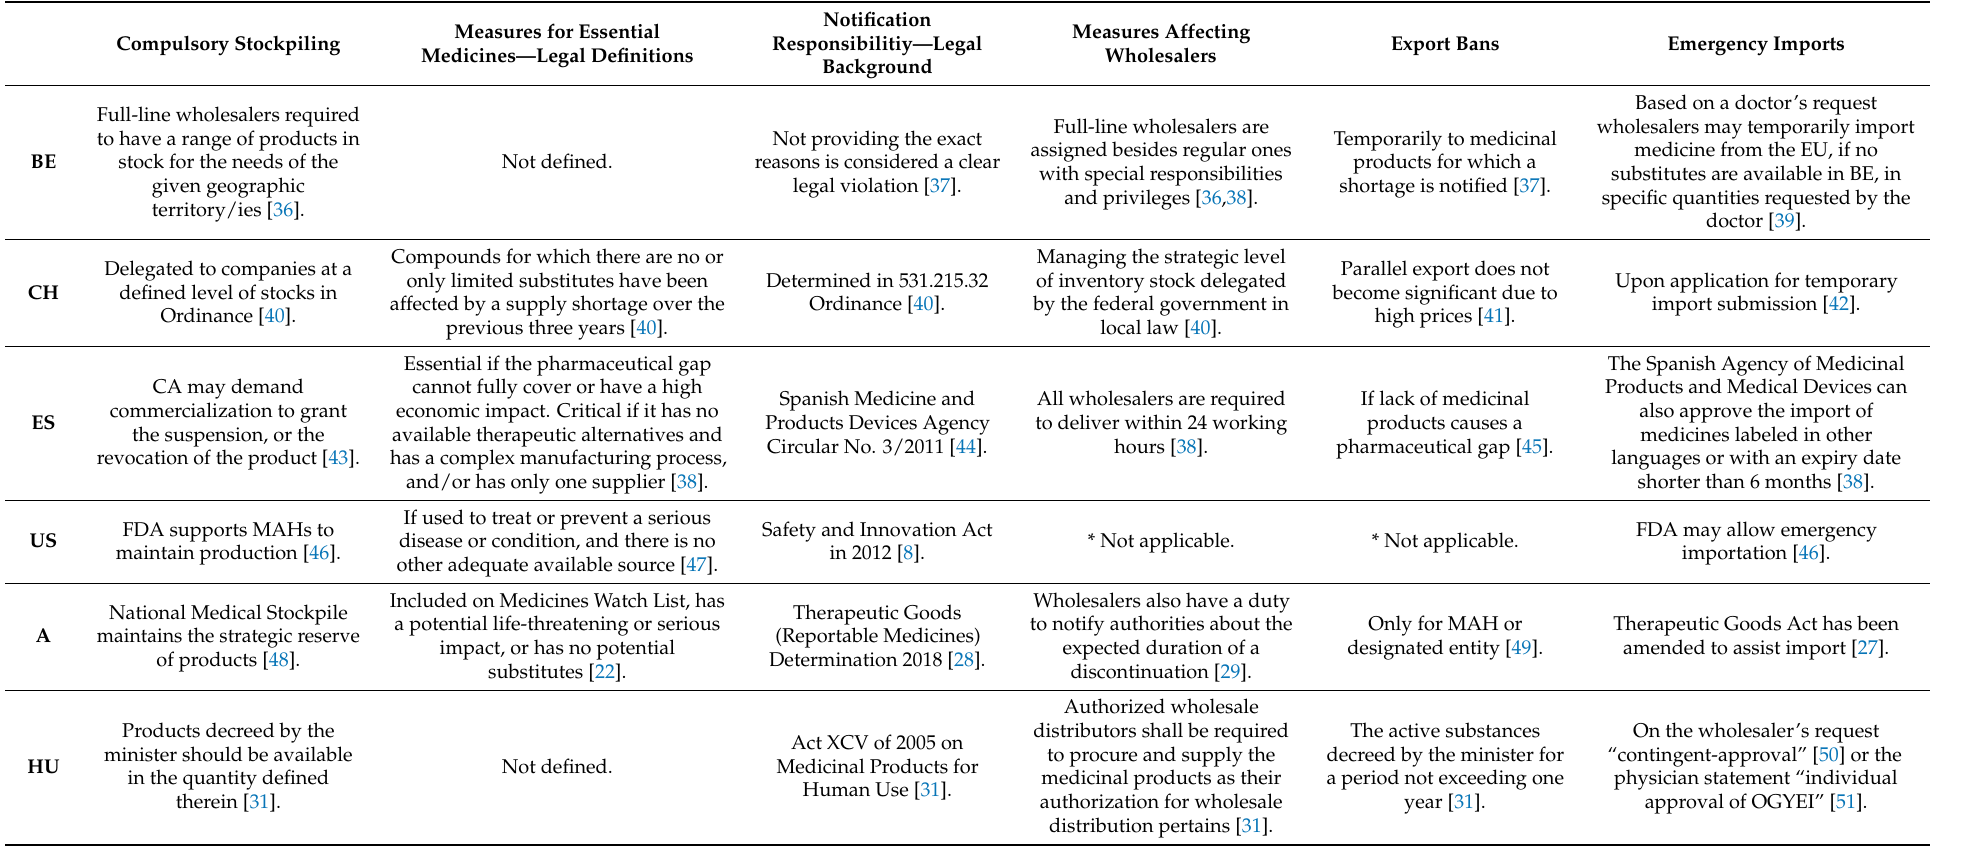
Table 6. Countermeasures introduced by countries. * Not applicable means that we did not obtain relevant literature on this